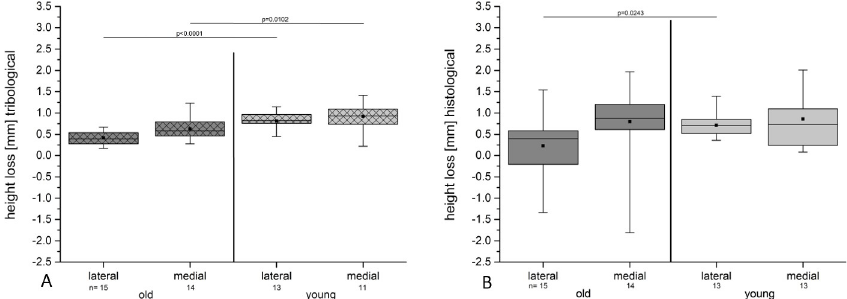
Fig 11. The results show a pronounced HL in the medial compartments both for the tribological and histological measurements in the old and in the young group. (A) The tribological assessment revealed significantly higher HL for the lateral and the medial compartments depending on the age of the animals. (B) The histological assessment showed a significantly higher HL only for the lateral compartment of the young group compared with the old group. Note the wider spread of data of the histological measurements compared to that of the tribological